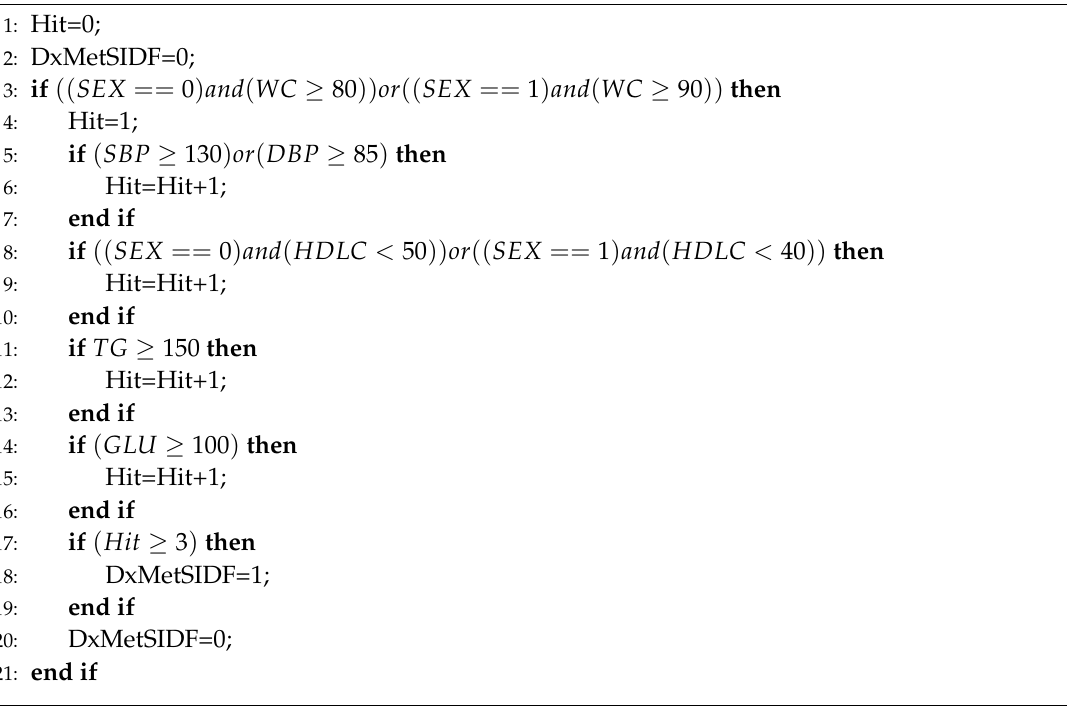
Algorithm A1 Algorithm to diagnostic MetS with IDF criteria.